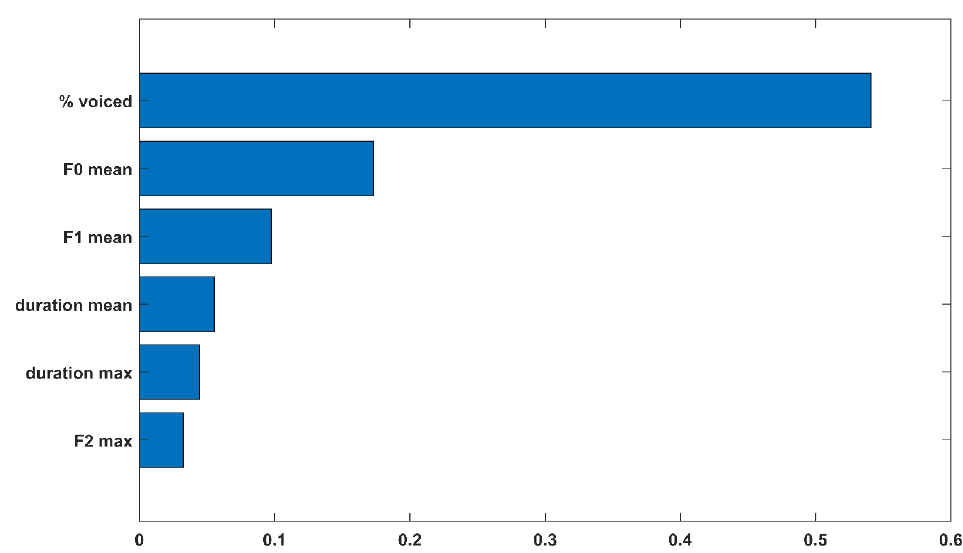
Figure 2. Acoustical parameters sorted in descending order on the basis of the ratio between their weight and the total weight for the G index.